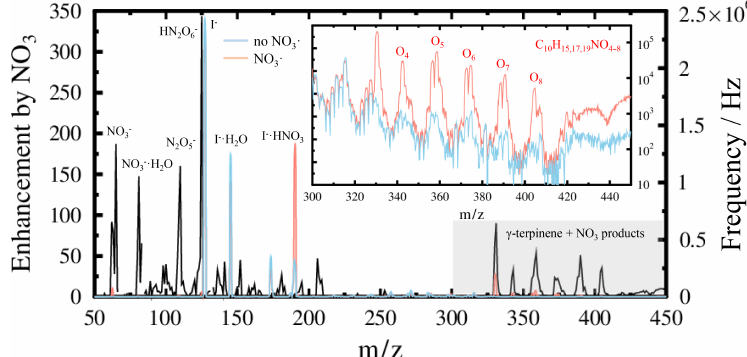
Figure 8. CIMS mass spectra before (blue) and after (red) γ -terpinene oxidation by NO 3 correspond to right axis. Signal enhancement by addition of NO 3 is shown in the black trace. The inset panel shows an enhanced region of the mass spectra corresponding to the shaded area, which indicates the presence of multifunctional ON compounds with the number of oxygen atoms consistent with the depicted chemical formula. The “O 4 ” peak was used to quantify hydroxy nitrate concentrations. Signal enhancement by addition of NO 3 is shown in the black